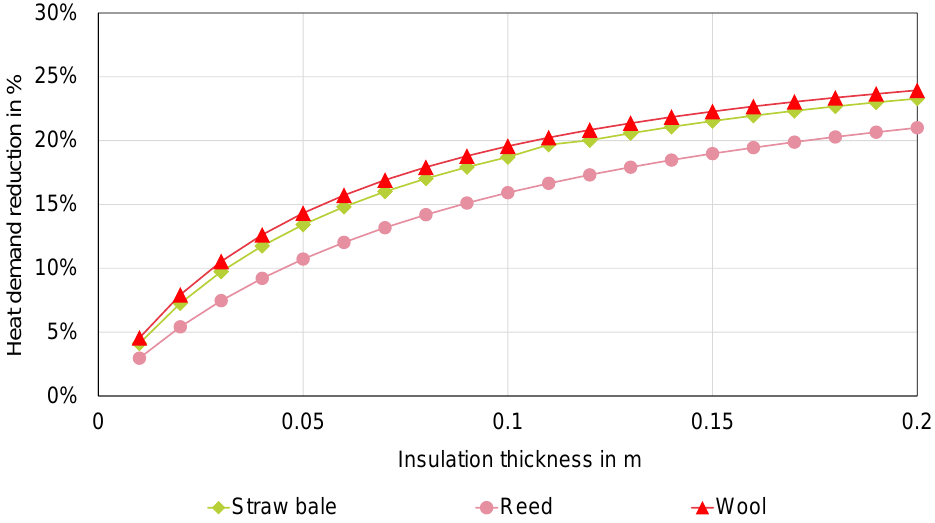
Figure 20. Ceiling insulation with locally available insulation materials with varying thicknesses of the insulation layer to present the potential of natural insulation materials in rural Kyrgyzstan.